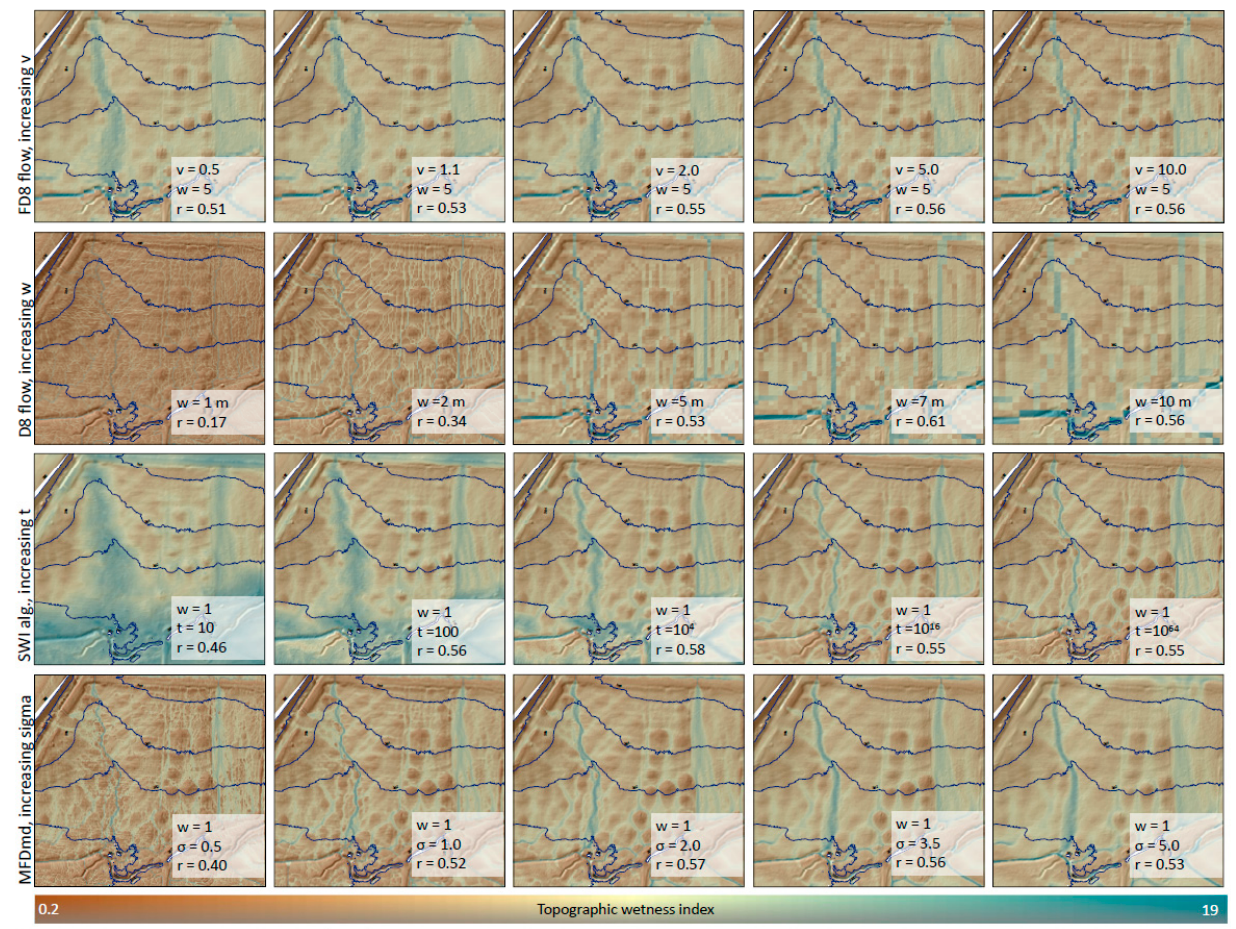
Figure 5. Selected output examples of TWI. Each row shows the effect of increasing a single factor on a set of TWI calculations. Terms used: v = convergence index value; w = pixel resolution; t = SAGA wetness index suction factor; r = Pearson correlation between TWI and average observed soil moisture; σ = standard deviation (meters) of the Gaussian curve used for DEM filtration.